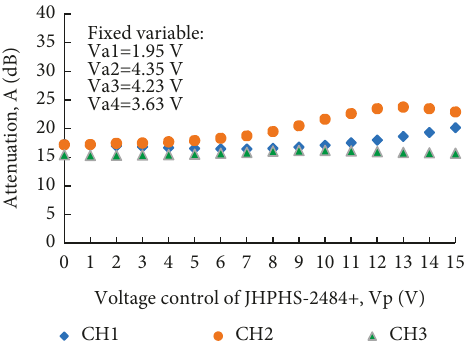
Figure 19: Attenuation, A q, of each channel when V pp varies from 0–15V and V aq is kept constant.